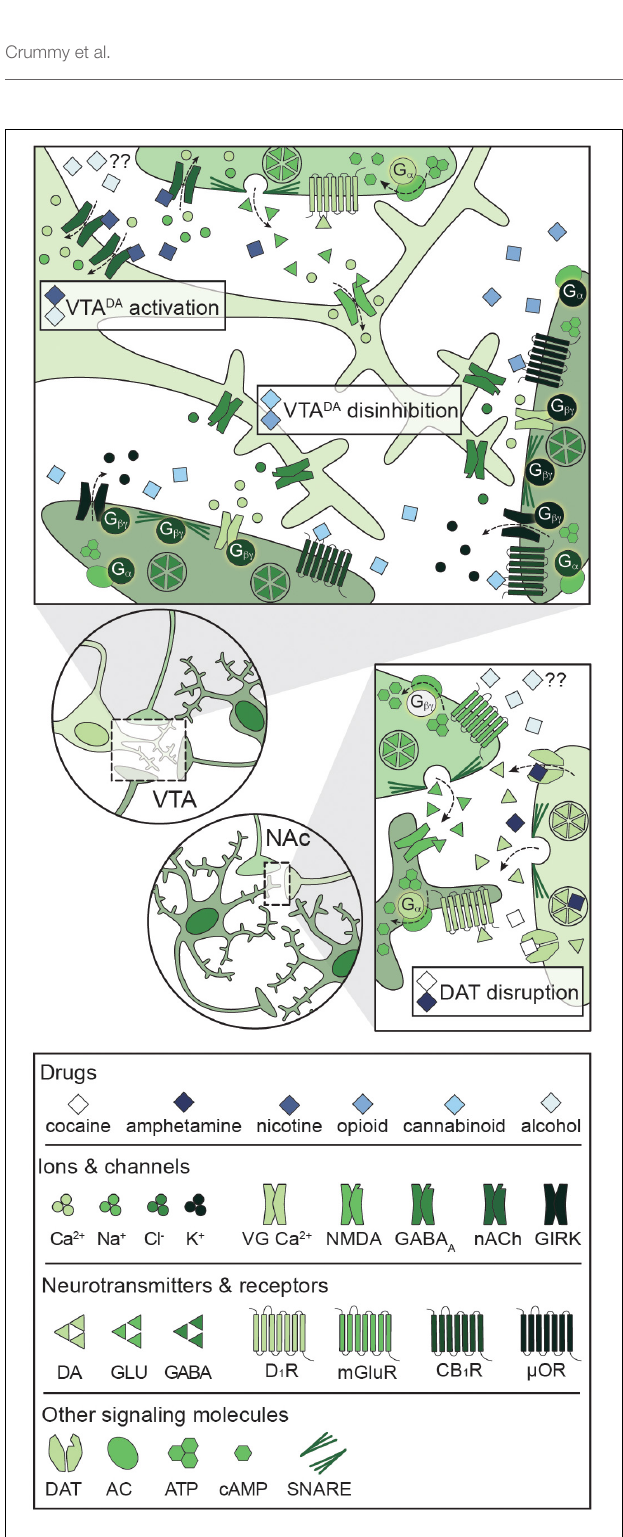
FIGURE 4 | Primary mechanisms of action of potentially addictive drugs. Potentially addictive drugs increase DA release into the NAc, but different drugs act via distinct mechanisms. Top : Opioids and cannabinoids disinhibit VTA DA neurons via presynaptic inhibition of VTA GABA and NAc MSN inputs through four notable mechanisms: Inhibition of VG Ca 2 + channels, activation of GIRKs, inactivation of AC, and inhibition of GABA release. Nicotine activates VTA DA neurons via direct activation of somatodendritic nAChRs and